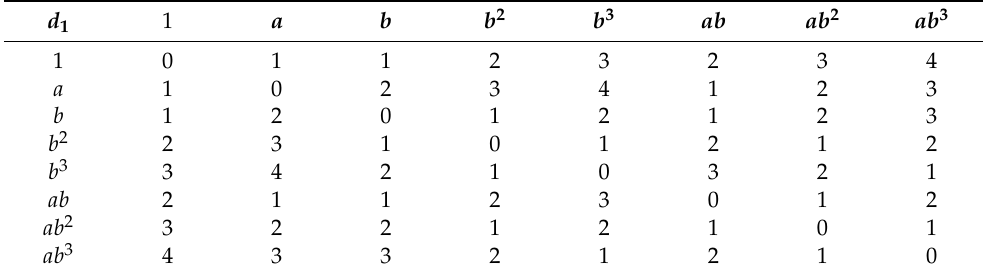
Table 1. Table of distances of Z 2 × Z 4 , D 4 , and Q 8 .